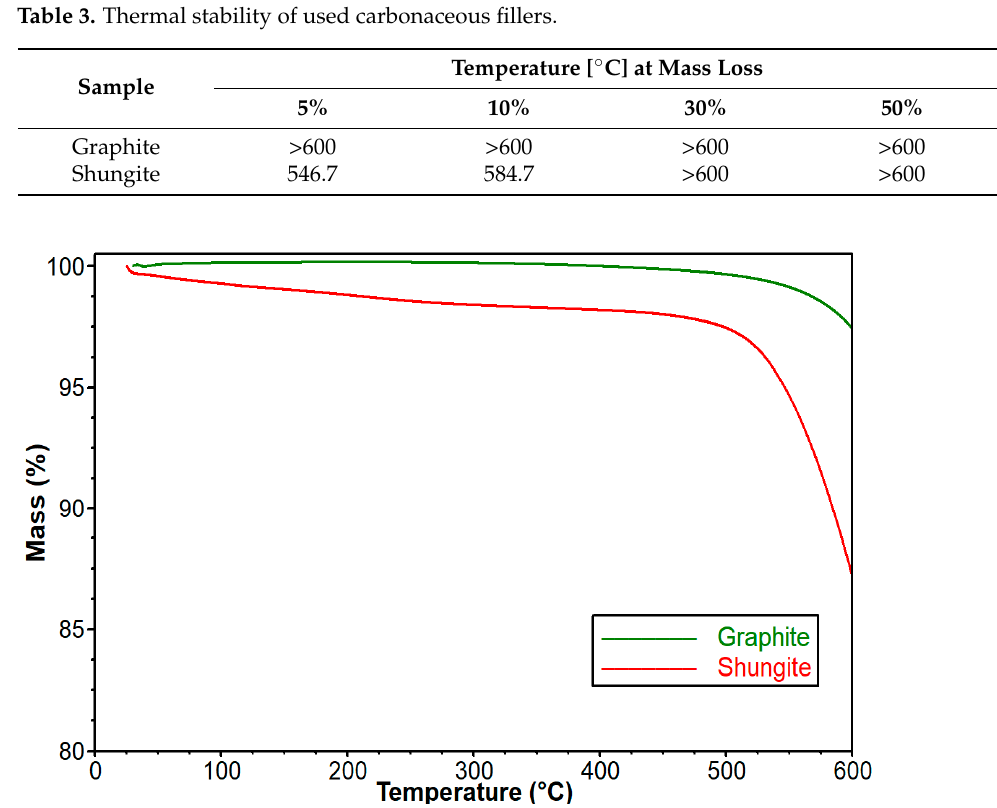
Figure 10. Thermogravimetric curves for carbonaceous filler: shungite and graphite. Table 3. Thermal stability of used carbonaceous fillers.